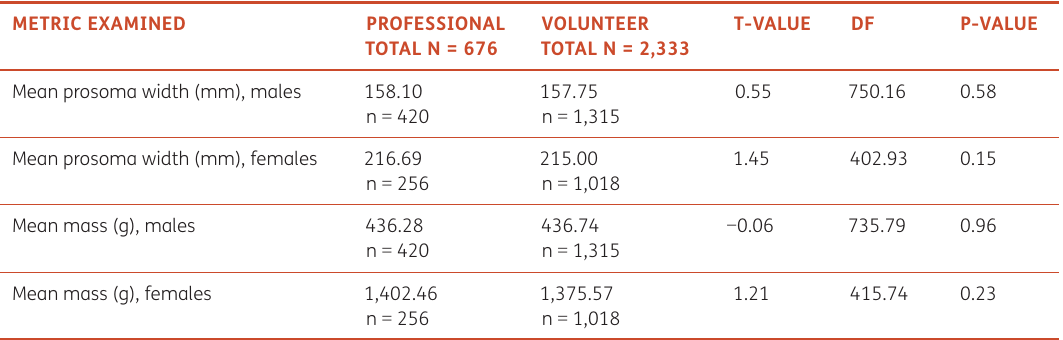
Table 2 Results of Welch’s t-test for unequal variance used to compare means of prosoma width and mass of horseshoe crabs by sex, as recorded by a professional or by a